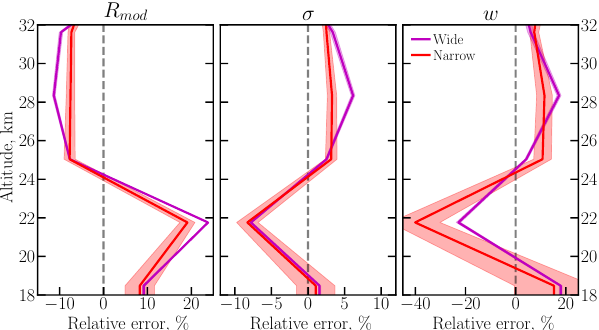
Figure 8. Relative errors for R mod , σ and derived w for the volcanic scenarios with perturbed R mod , σ , N for a typical tropical observa- tion geometry. The shaded areas stand for ± 1 standard deviation. The scenarios used for the simulations are listed in Table